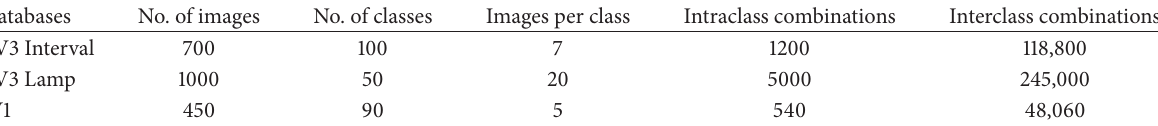
Table 1: The profiles of iris image databases.